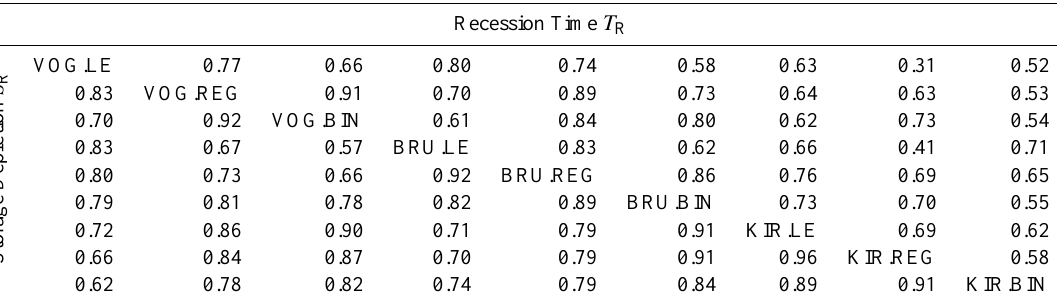
Table 2. Spearman’s rank correlation coefficient ( ρ) for recession times T R (above diagonal) and storage depletions S R (below diagonal) calculated for pairs of all